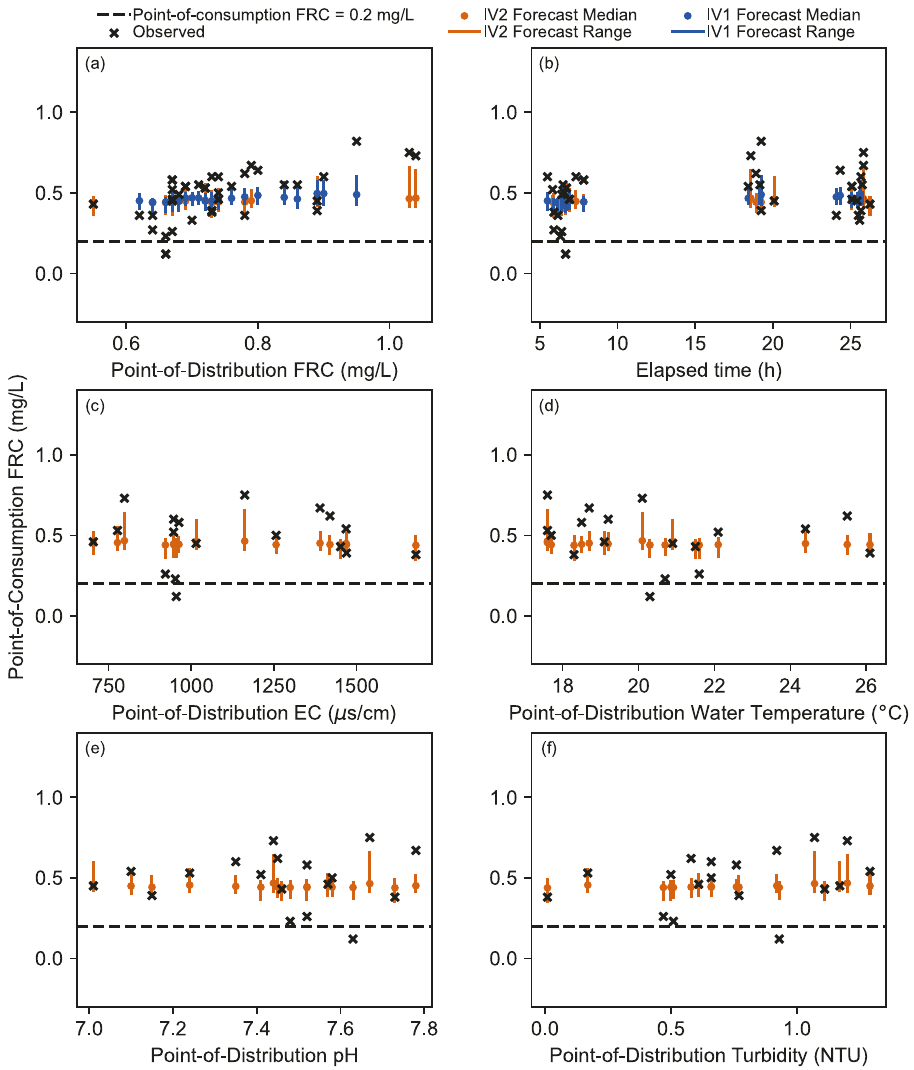
Fig. 5 Jordan (2015) observations and post-processed forecasts of point-of-consumption FRC. The observations and forecasts are shown against a point-of-distribution FRC, b elapsed time, c point-of-distribution EC, d point-of-distribution water temperature, e point-of- distribution pH, f point-of-distribution turbidity. Both IV1 and IV2 forecasts are very fl at due to low overall rates of FRC decay at this